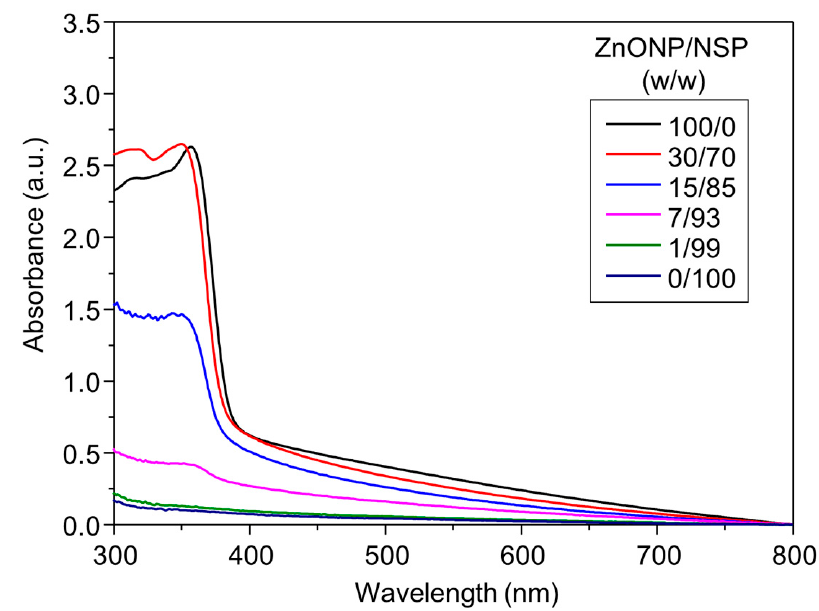
Figure 1. Characterization of UV-Vis absorption (380 nm) of ZnONP/NSP at di ff erent weight ratios (on the basis of 0.1 wt% solid content in all samples). Abbreviations: NSP, nano-silicate platelet; ZnONP, zinc oxide nanoparticle; ZnONP/NSP, ZnONP on NSP.